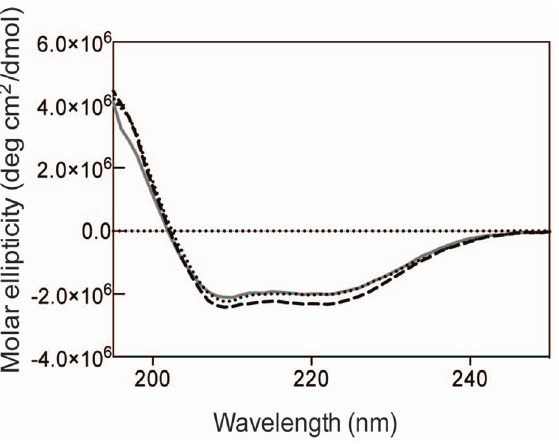
Figure 2. a -DsbB is helical. CD spectra in the far UV region of oxidized wt a -DsbB (dotted line) and [CCSS] (dashed line) and [SSCC] (solid line) variants. The spectra shown are the mean of three replicates.